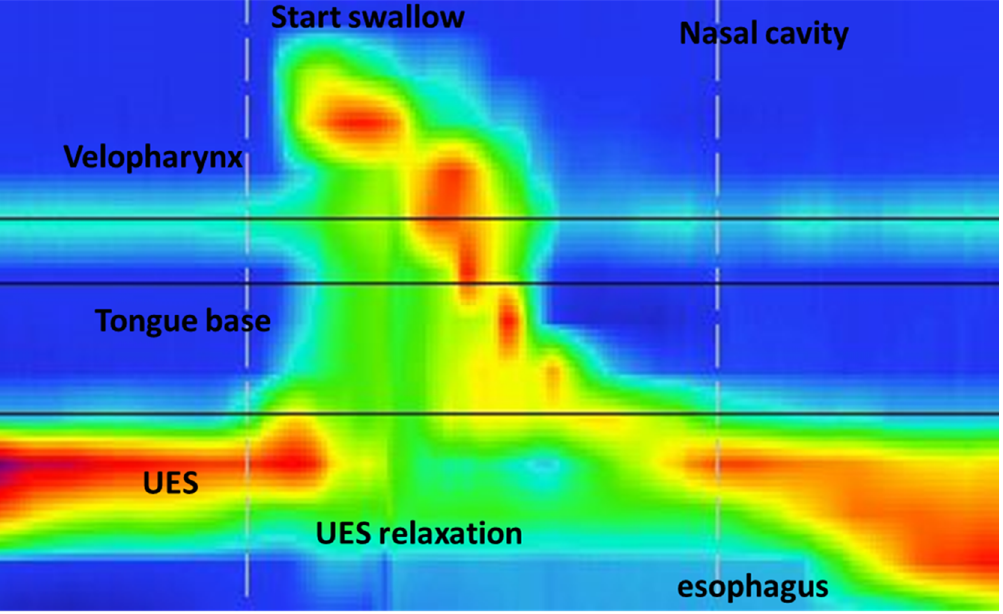
Figure 1. High-resolution manometry (HRM) with swallowing analysis. Regions of interest for HRM procedure between nasal cavity and esophagus. Velopharynx (VP), tongue base (TB) and UES are described. Start of swallow and UES relaxation are shown.